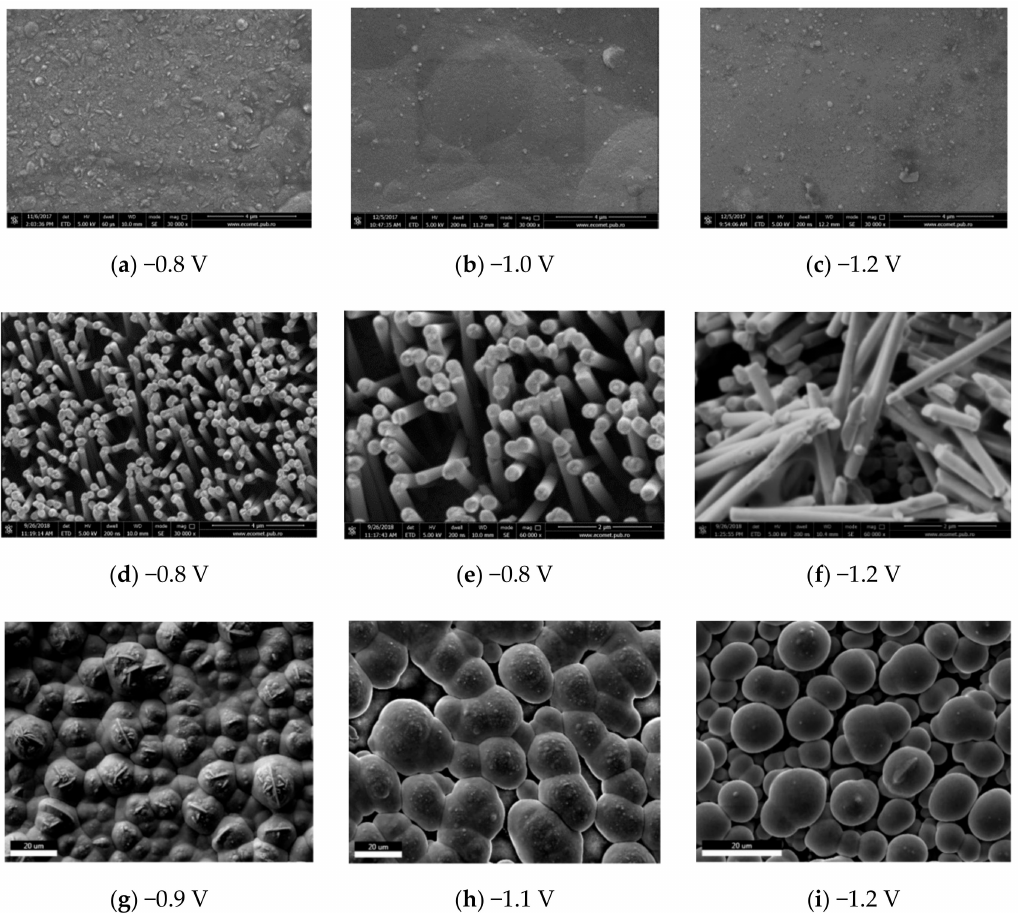
Figure 4. Scanning electron microscopy (SEM) images of Co-Ni film deposited on Au for 15 min ( a – c ), Co-Ni NW array deposited on Au for 5 min ( d – f ) and Co-Ni overgrown NWs deposited for 15 min ( g – i ) nanowire array: ( a ) perspective view of the NWs array deposited at − 0.8V ( × 30,000); ( b ) NWs deposited at − 0.8 V ( × 60,000); ( c ) NWs deposited at − 1.2 V ( ×